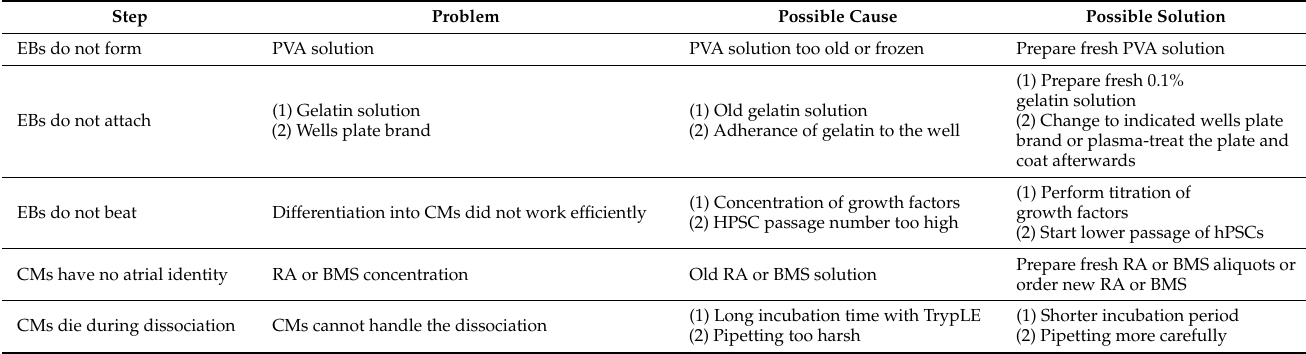
Table 1. Troubleshooting of different problems that may occur during differentiation